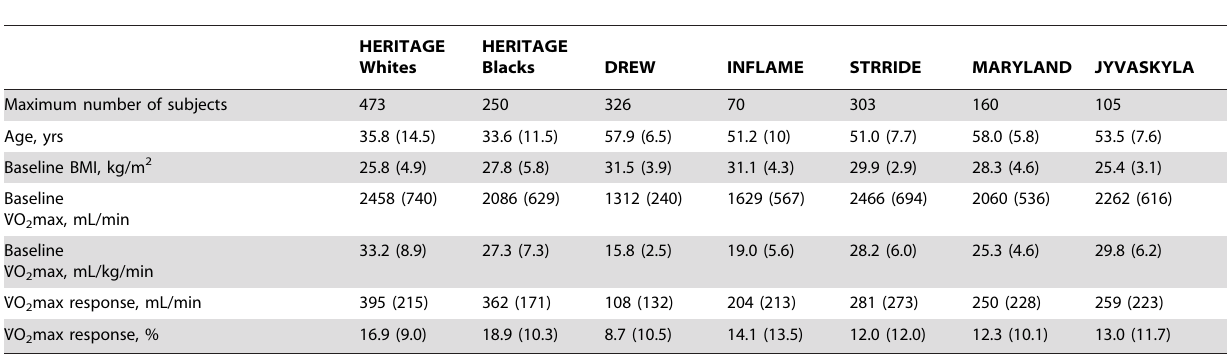
Table 2. Descriptive Data, Including Baseline V˙O 2 max and its Response to Training, for the Six